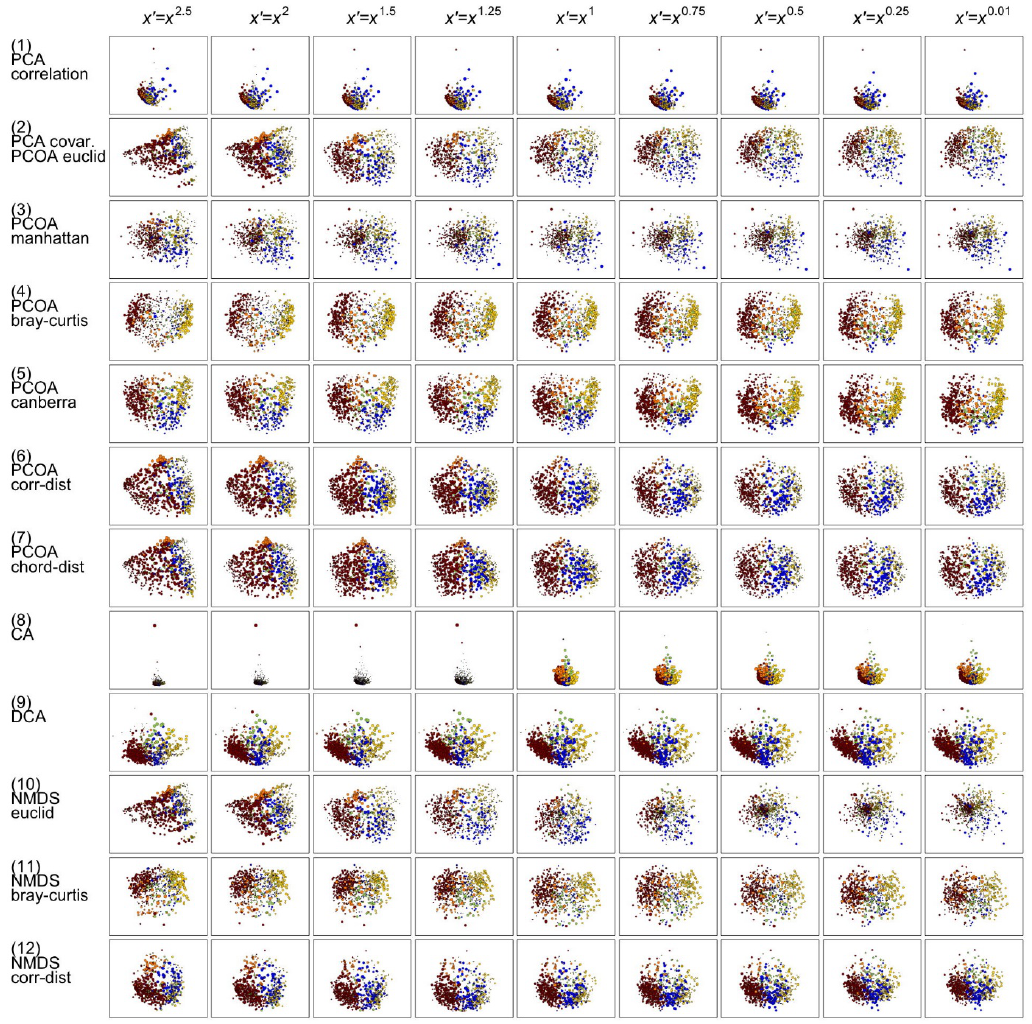
Figure 5. The panel of ordinations, obtained with the data frame “ws200”, n = 726. Variation of ordination in the vertical direction is caused by changing methods, and in the horizontal direction by alternative data transformations. The classification of data points (colours) serves as an ease of visual comparison only, and has no effect on the results.